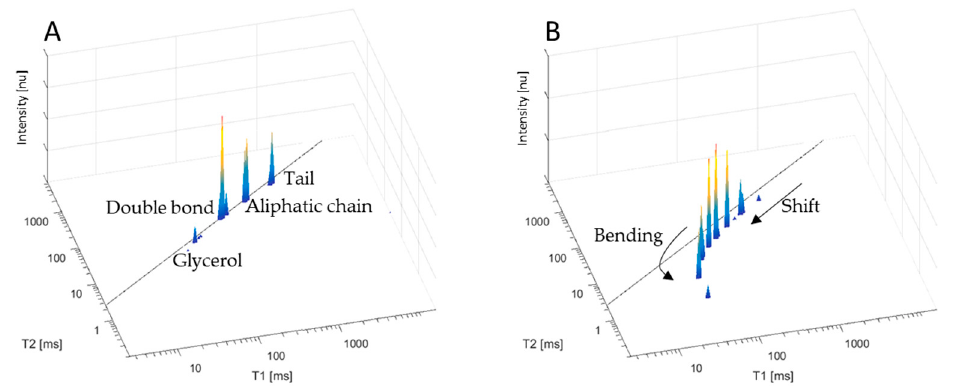
Figure 1. Chemical and morphological TD NMR sensor 2D T 1 -T 2 relaxation times of linseed oil before ( A ) and after 120 h of thermal oxidation at 80 ◦ C plus air pumping ( B ).